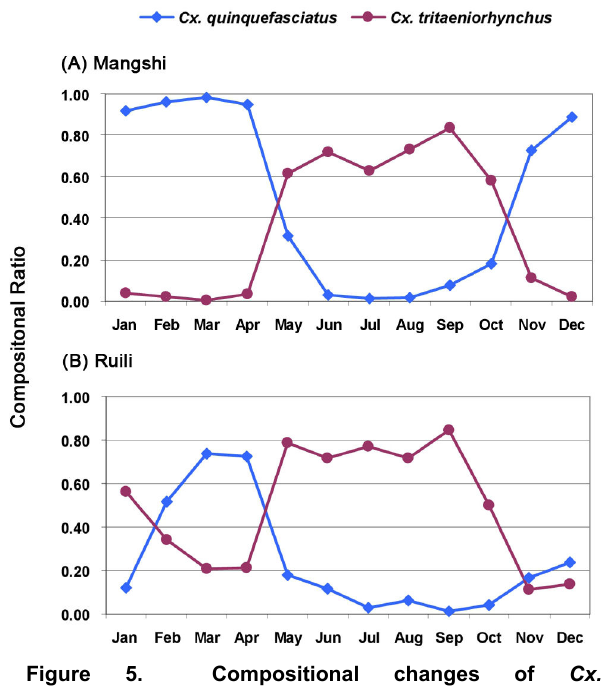
Compositional changes of